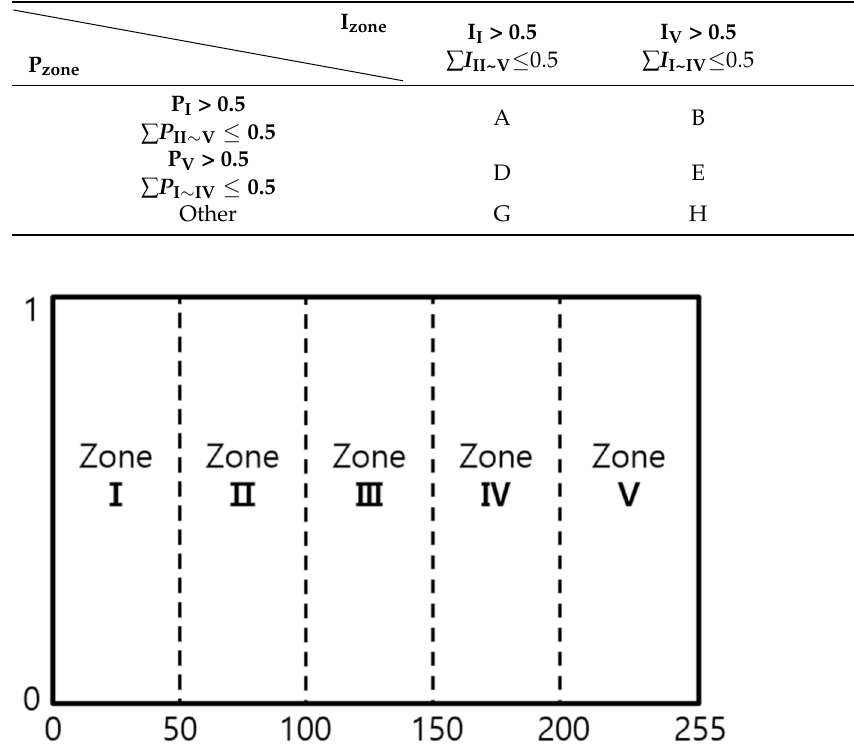
Figure 4. Example of normalization: ( a ) Original image; ( b ) Histogram of original image; ( c ) Normalized histogram of original image. Table 1. Type by the brightness and contrast.